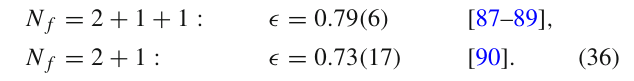
Fig. 8 Forward scattering amplitude (left) and self-energy contraction (right). The thick black dots denote kaon electromagnetic form factor insertions, the dashed line indicates the kaon pole. Crossed diagrams are